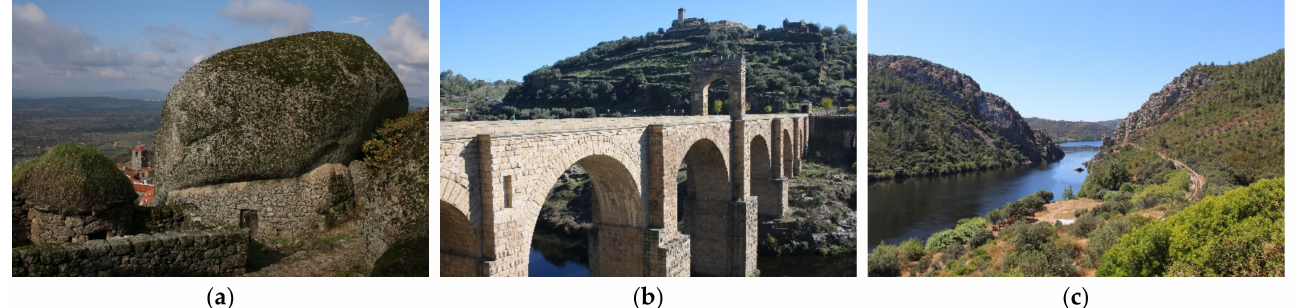
Figure 2. ( a ): Monsanto historic village. ( b ): Roman bridge at Alc á ntara. ( c ): Natural Monument of “Portas de R ó d ã